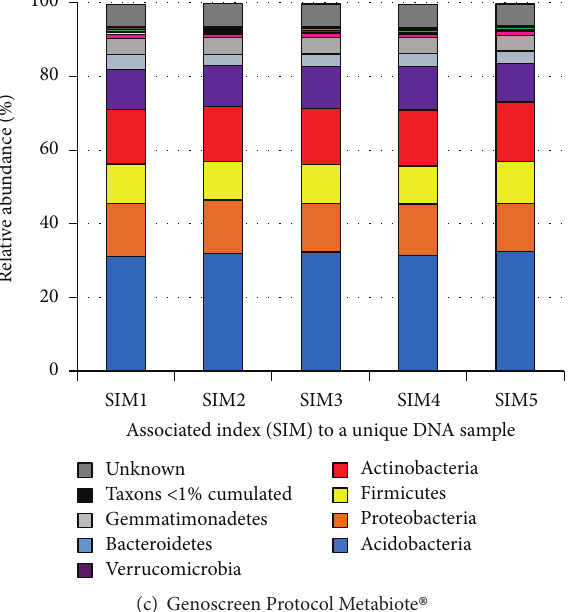
Figure 1: Impact of three different 16S-amplicon library preparation methods on the observed relative abundance of bacterial taxa. One unique sample of soil (known to have the highest microbial community complexity) was used to compare three distinct methods of molecular indexing such as MID (multiplex identifier) or Genoscreen-developed sample identifier multiplex (SIM). Five examples of final bacterial profiling are shown for each of the three methods used to illustrate the reproducibility of DNA